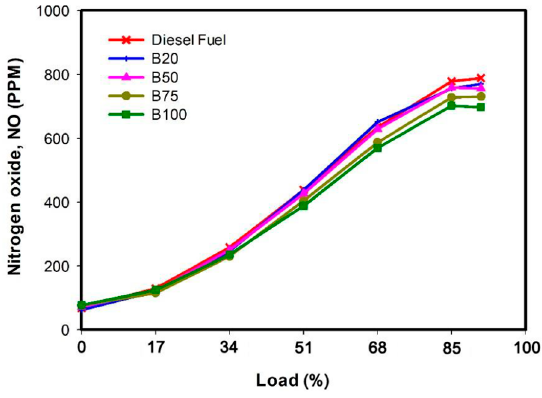
Figure 12. Variations of NO with engine load for diesel, sheep fat biodiesel (B100) and biodiesel blends (B20, B50 and B75) fuels.